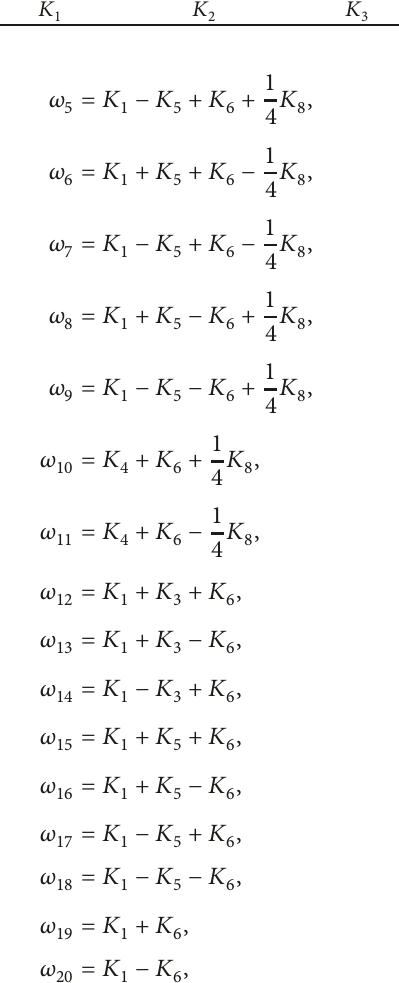
correspond to the elements in the optimal system (28) are